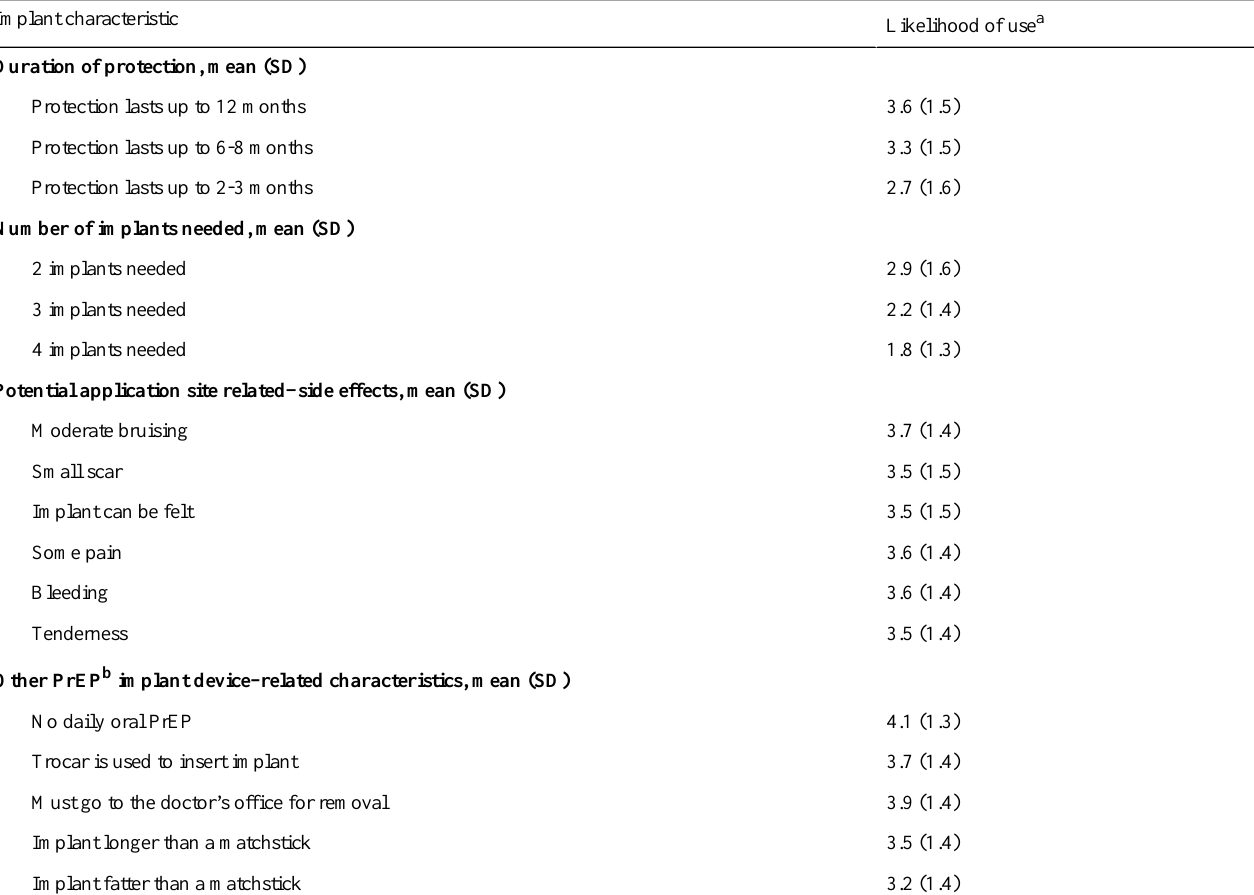
Likelihood of use a Implant characteristic